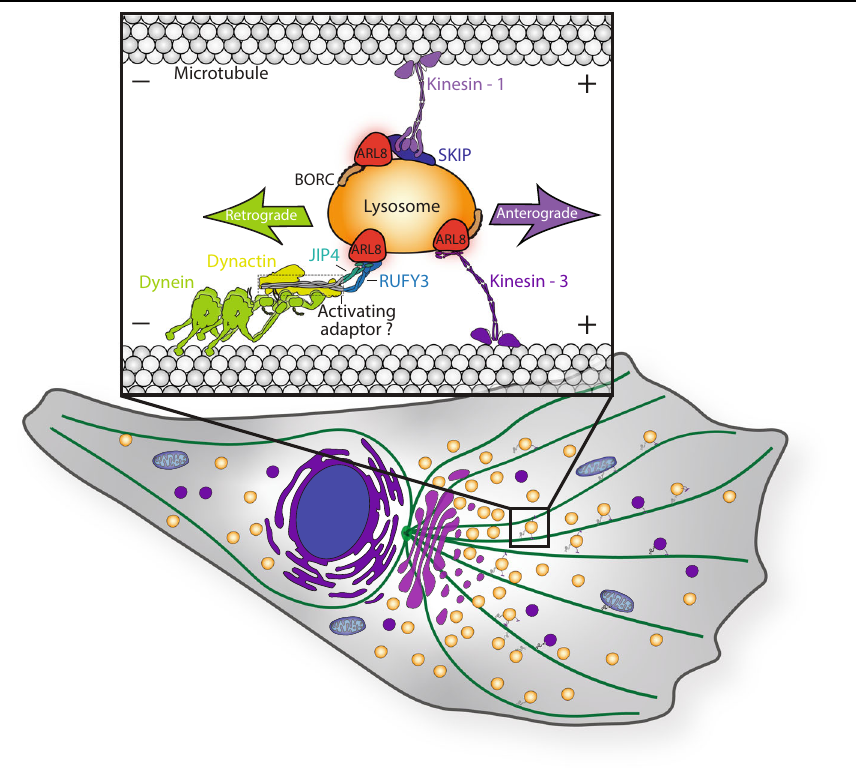
Fig. 1 | Bidirectional lysosome movement is mediated by ARL8. Lysosomes (orange)aretransportedintheanterogradedirectiontowardsthecellperipheryor in the retrograde direction toward the cell center on microtubule tracks (green). Inset: ARL8 (red) interacts with the BORC complex and links lysosomes directly to kinesin-3 or to kinesin-1 via SKIP for anterograde transport. ARL8 interacts with